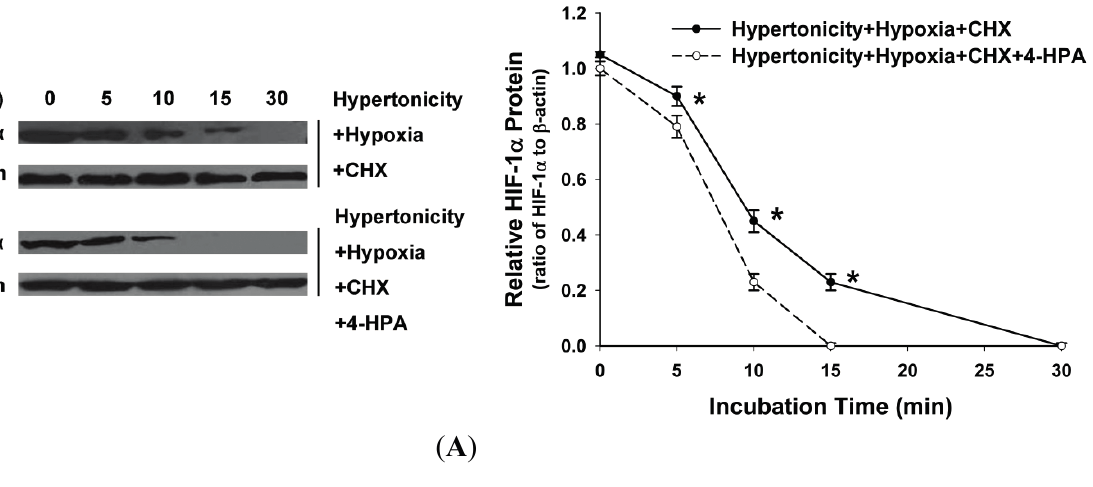
Figure 7. Effects of 4-HPA on HIF-1 α protein degradation under hypertonicty and hypoxia conditions in primary AEC. AEC were treated with hypertonicity ( C ); hypoxia ( B ); or both of the two ( A ) with or without 4-HPA treatment for 4 h, followed by incubation with 100 μ M cycloheximide (CHX, blocking ongoing protein synthesis) from 0–30 min. Cell lysates were subjected to Western blotting using antibodies against HIF-1 α and β -actin (the left panel) and the intensity of HIF-1 α protein relative content was quantified (the right panel). The plot represented means ± SD from three independent experiments, * p < 0.05 vs. groups with 4-HPA treatment; and ( D ) prolyl hydroxylase domain enzyme isoform-2 (PHD2) protein of AEC which were treated with both hypertonicity and hypoxia in the presence and absence of 4-HPA was detected by Western blotting. Data are means ±